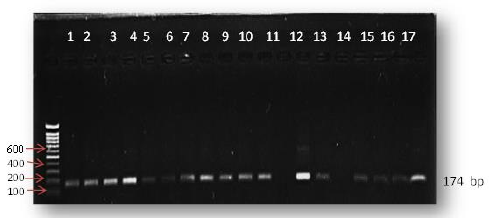
Fig. 1. The electrophoresis pattern ofDNA extracted from blood for patients with type 2 diabetes and control,1% agarose ,75V,20Am for 1h.(10µl in each well).lane 1-5 DNA from patient, lane 6-10 DNA from control